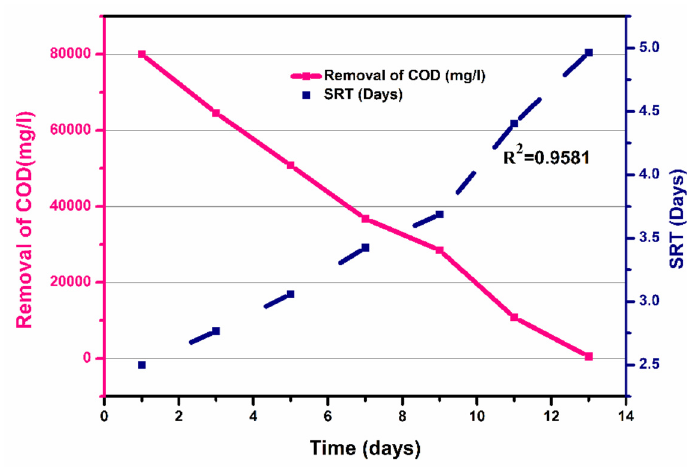
Figure 8. Removal of COD and efficiency of the process over time.